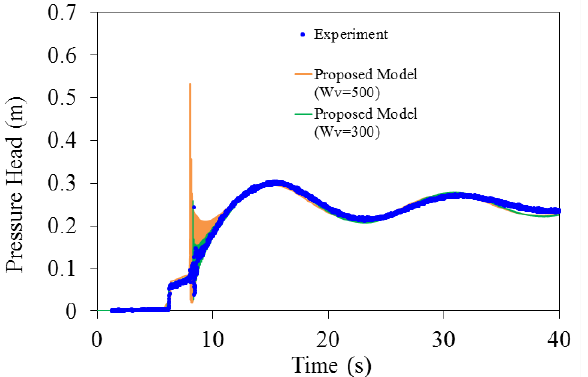
Figure 7. Comparing numerical and experimental pressure head time histories at 9.9 m from the upstream tank (acoustic speed = 300 m/s).